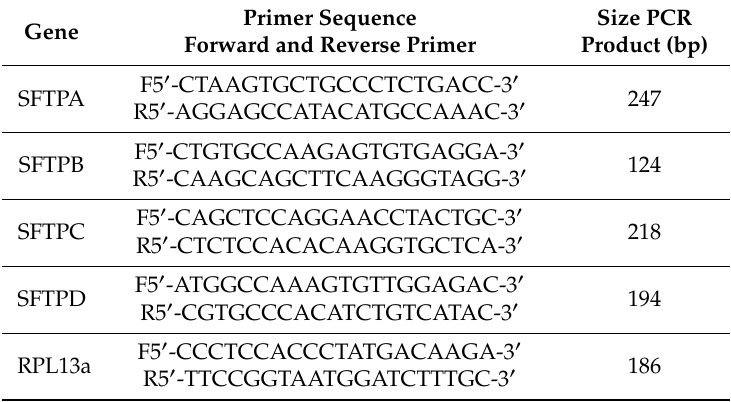
Table 3. SP-gen-specific sequences for the detection of SP-A, SP-B, SP-C, SP-D, and the housekeeping gene ribosomal protein L13a (RPL13a). ( F ) Forward and ( R ) reverse primer; ( bp ) base pair [53]. Primer Gene